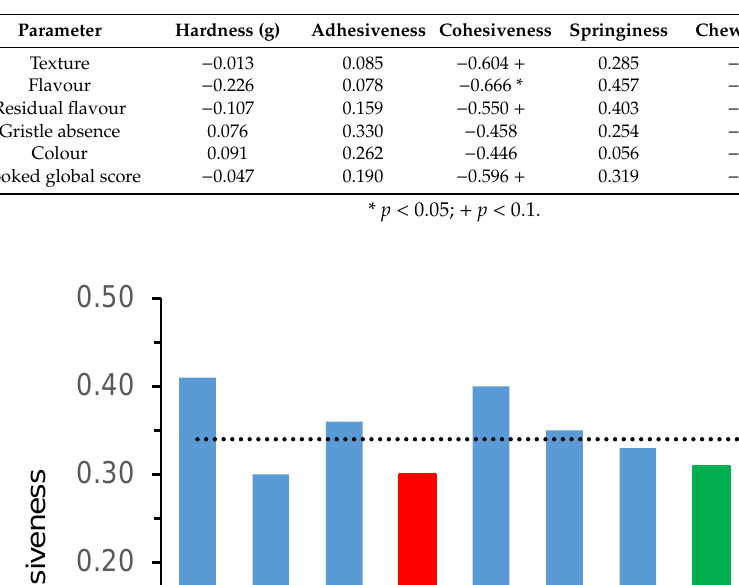
Table 8. Pearson’s correlation coefficients ( r ) between sensory evaluation scores and the instrumental textural analysis (TPA and Warner-Bratzler shear force test WBSF) in the samples selected for step 3 ( n = 10).